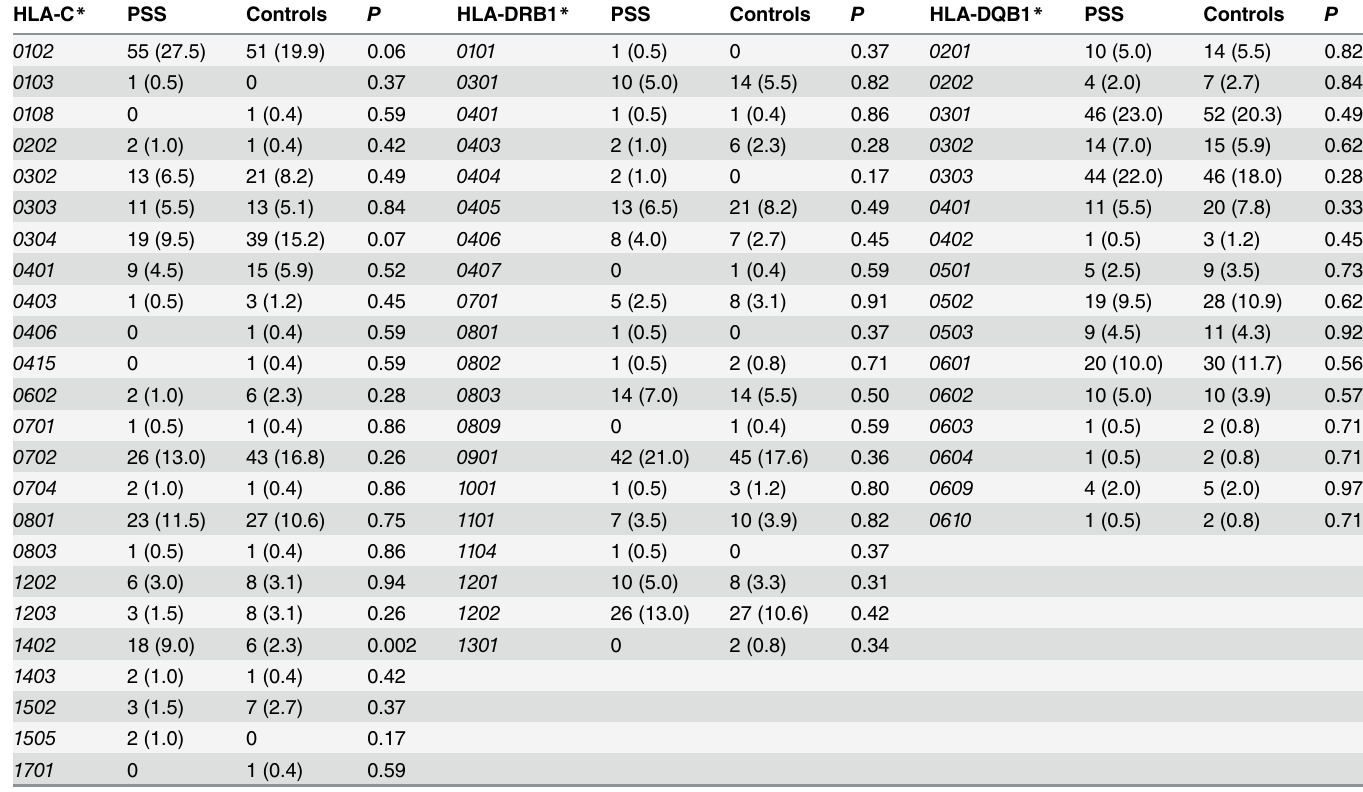
Table 3. Frequencies of HLA-C,-DQB1 and-DQB1 alleles in PSS cases and controls.